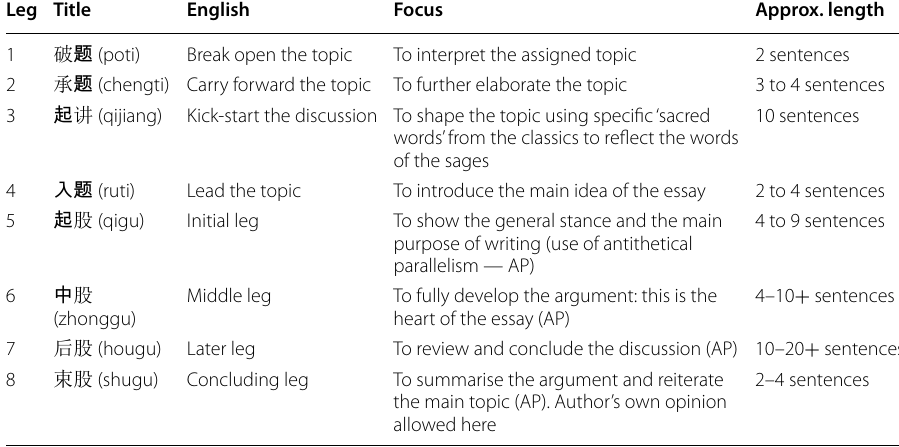
Antithetical parallelism is where two points are made, with the second contrasting or negating the